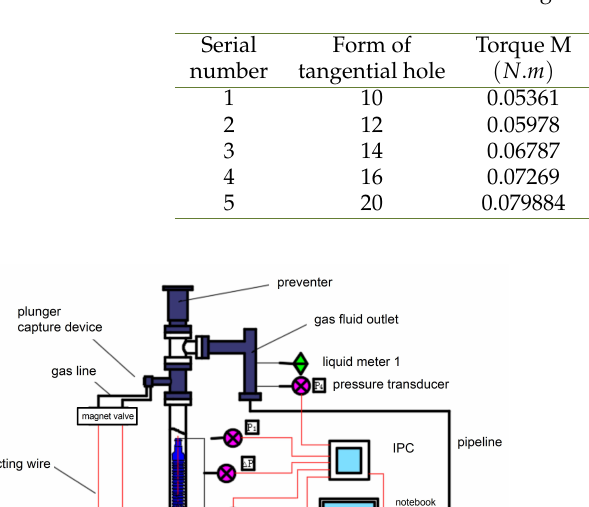
Table 5. Influence of tangential hole on plunger.